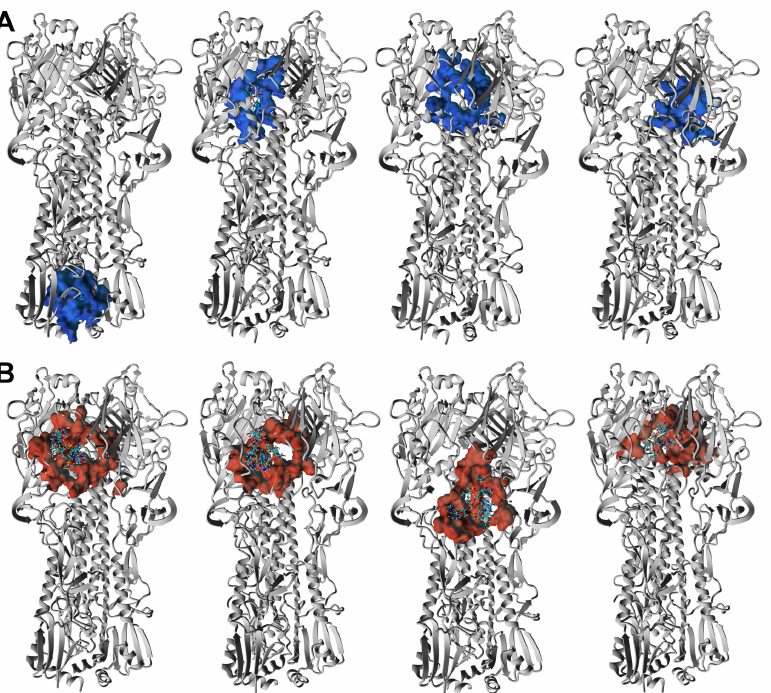
Figure 7. 3D structure of the four lowest energy complexes of the HA3 with A3-ORNs ( A ) and A3-ORNs-D-M ( B ) ligands. The surface of the HA3 residues involved in interactions with A3-ORNs and A3-ORNs-D-M substrates is highlighted as blue and red,